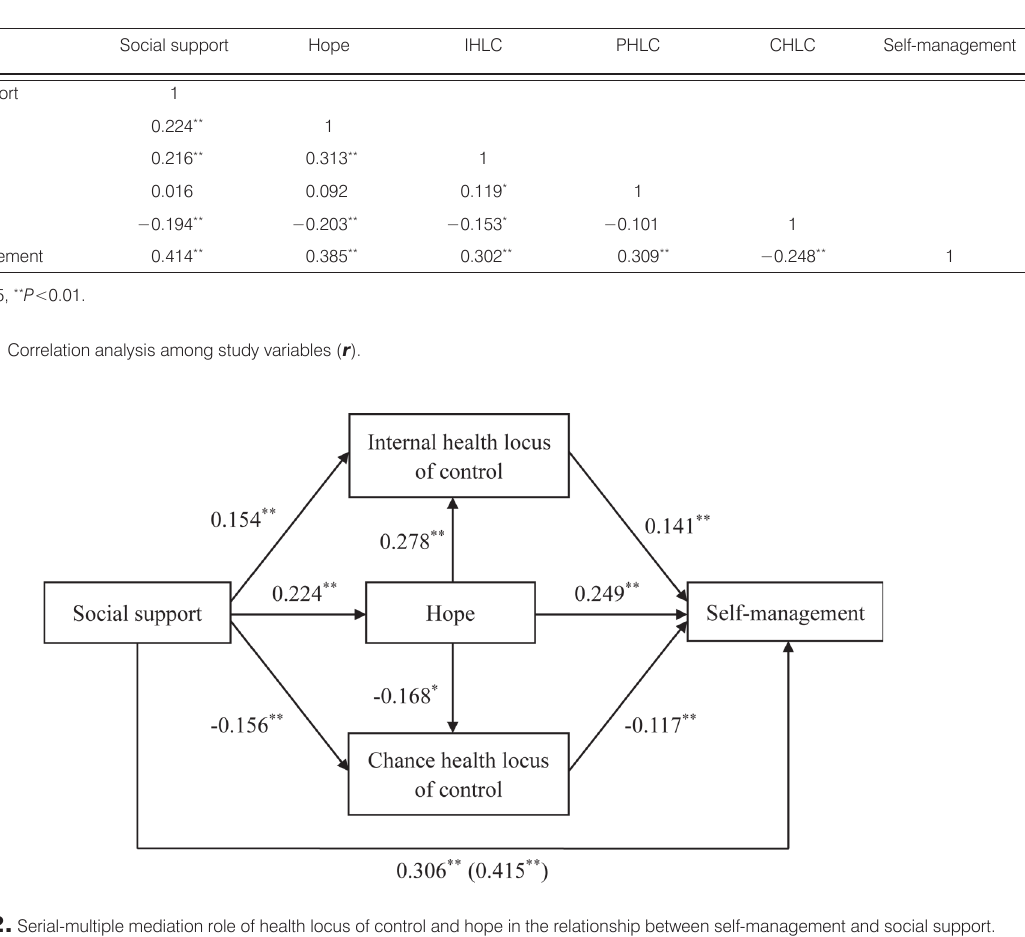
Figure 2. Serial-multiple mediation role of health locus of control and hope in the relationship between self-management and social support. Note: * P <0.05, ** P <0.01.